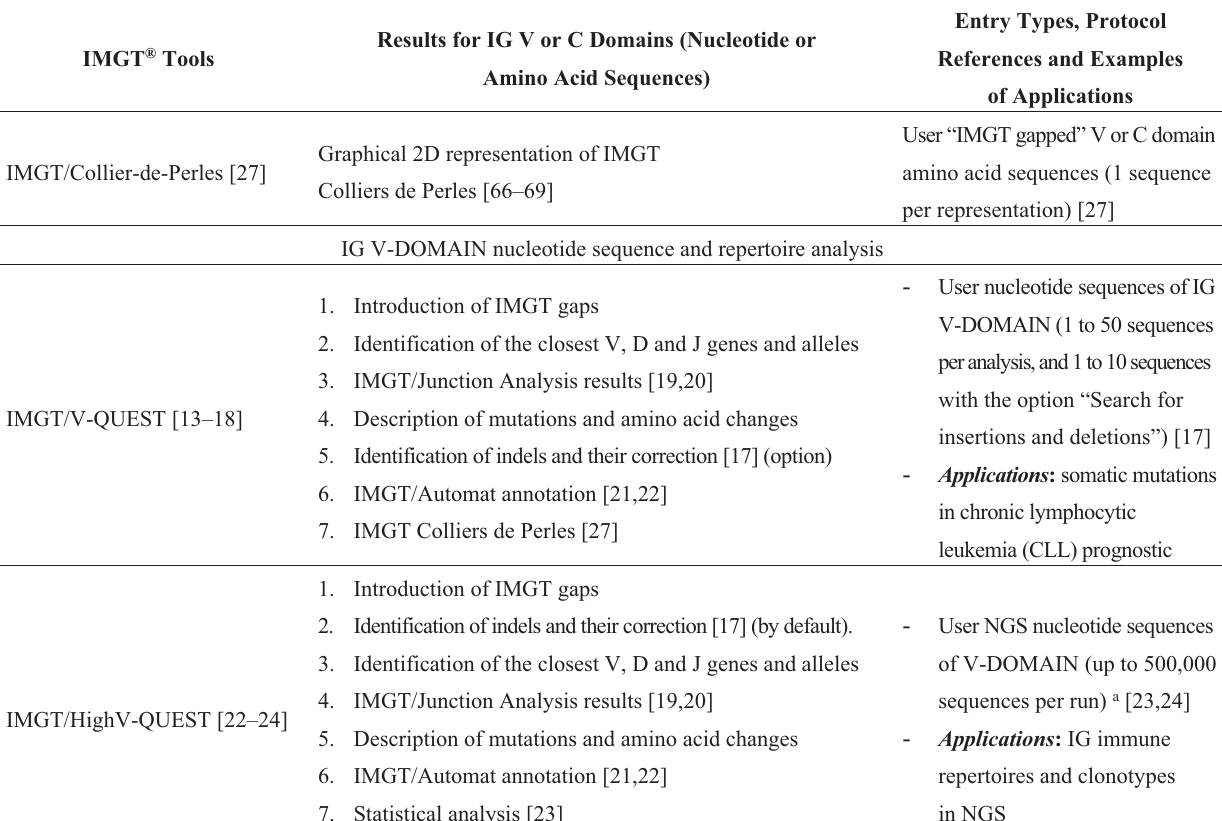
Table 5. IMGT ® tools and databases for the analysis of the IG V-DOMAIN and C-DOMAIN